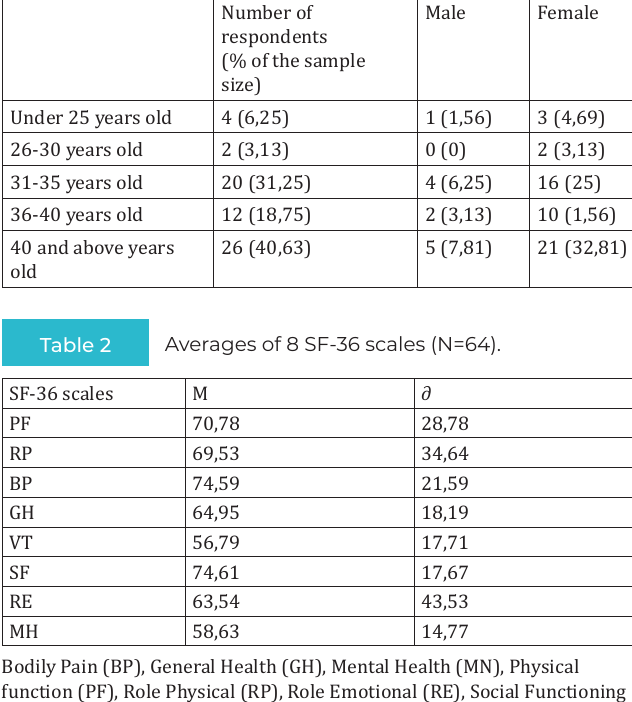
Bodily Pain (BP), General Health (GH), Mental Health (MN), Physical function (PF), Role Physical (RP), Role Emotional (RE), Social Functioning (SF), Vitality (VT).